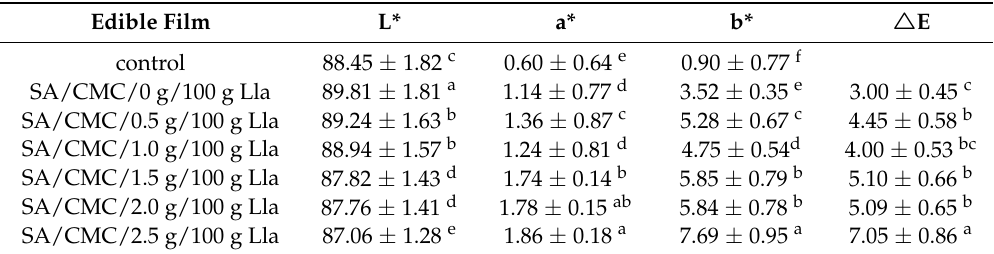
Table 2. Effect of the incorporation of Lactococcus lactis on color characteristics of biopolymer films. Edible Film L* a*